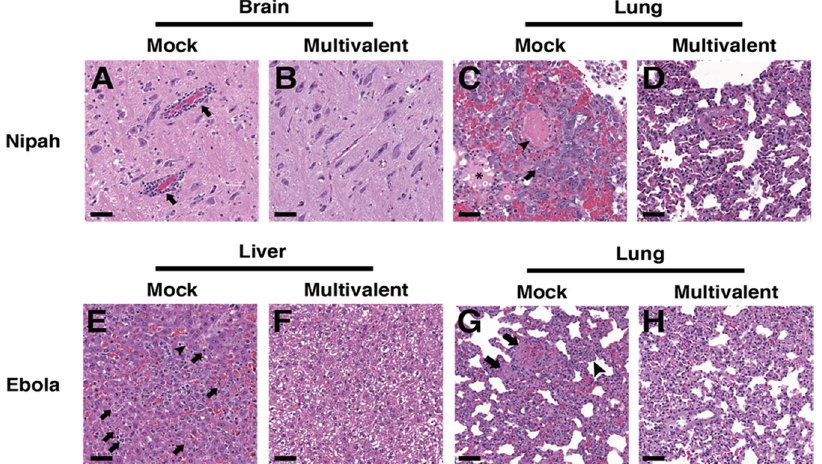
Fig. 10 Multivalent VSV virion vaccination prevented the development of histologic lesions in hamsters challenged with Nipah, Hendra, or Ebola viruses. Tissues from representative mock vaccinated ( A , C , E , G ) or multivalent VSV virion vaccination ( B , D , F , H ) following challenge with either Nipah ( A – D ) or Ebola virus ( E – H ). A Brain tissue from a representative mock vaccinated hamster with in fl ammatory perivascular cuffs (arrows). C Lung tissue from a representative mock vaccinated hamster with intravascular fi brin thrombi (arrowhead), edema in alveoli (asterisk), and type II pneumocyte hyperplasia with atypia (arrow). E Liver tissue from a representative mock vaccinated hamster with lobular hepatitis, hepatocyte necrosis (arrow), and intracytoplasmic viral inclusions (arrowhead). G Lung tissue from a representative mock vaccinated hamster with intravascular fi brinocellular debris (arrows) and expansion of alveolar septa with in fl ammatory cells (arrowhead). Lesions caused by Hendra virus resembled those caused by Nipah virus. H&E, scale bar = 50 μ